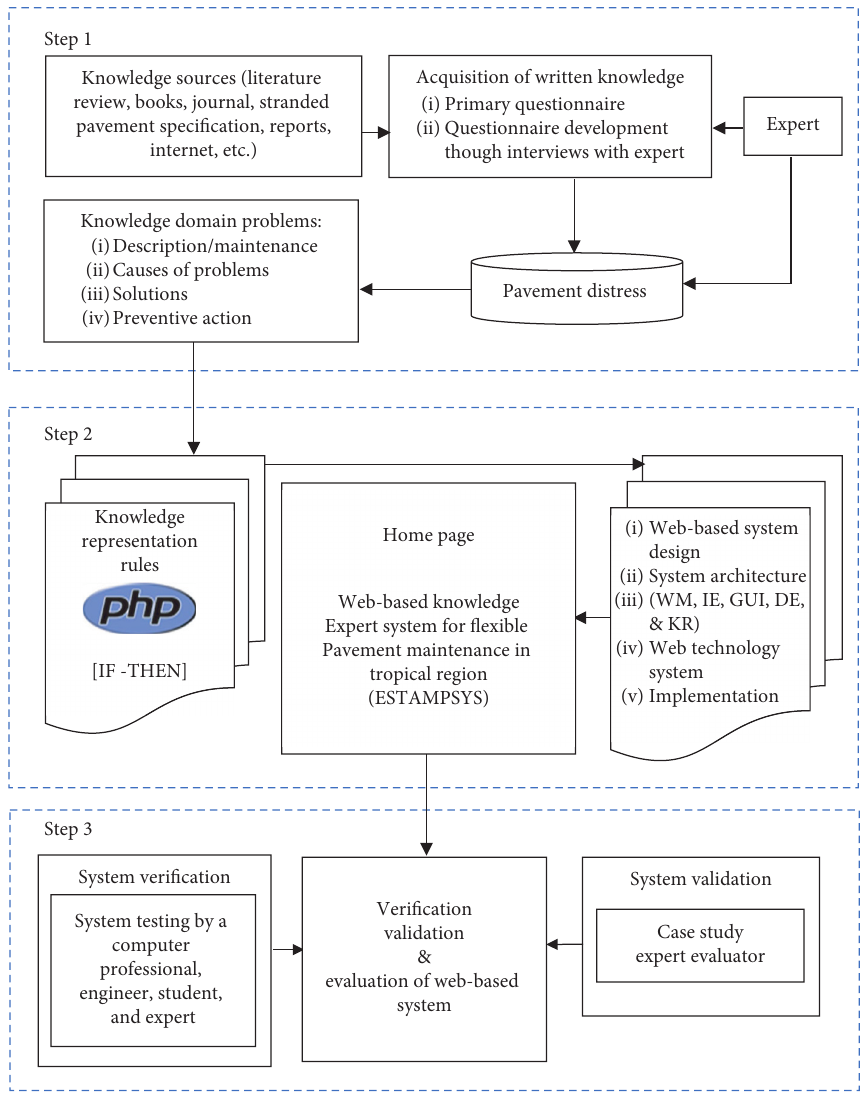
Figure 1: Flow chart of the system construction. Table 1: Questionnaire results for the importance of the system building